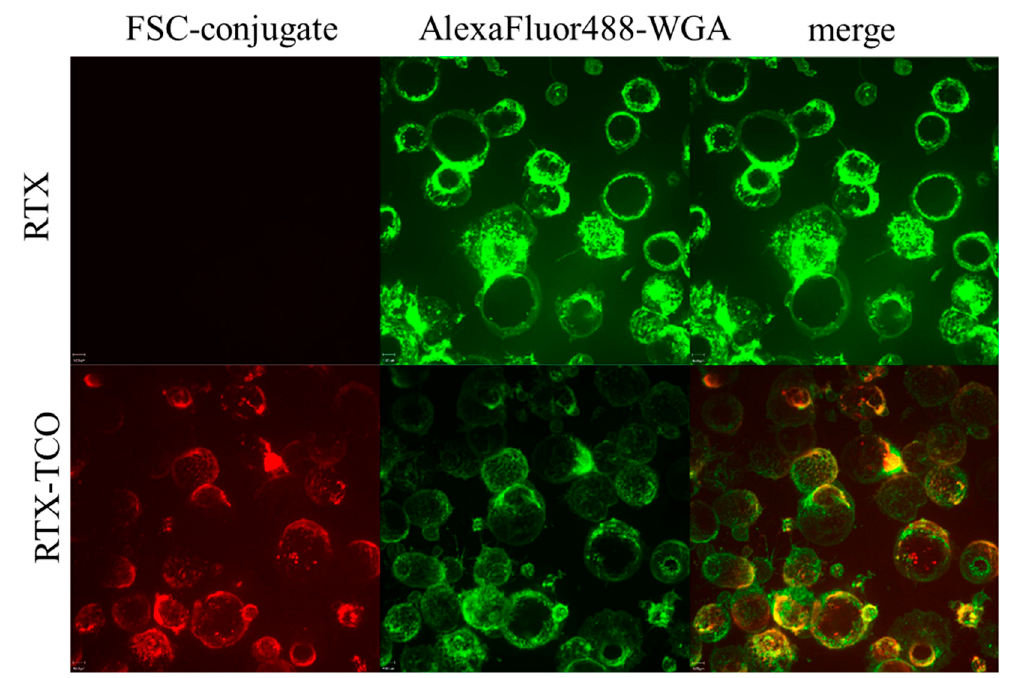
Figure 3. Fluorescence microscopy of CD20-expressing Raji cells pre-treated with RTX (upper lane) and with RTX–TCO (lower lane, negative control) prior to incubation with SulfoCy5-MAFC-PEG 5 -Tz. Each lane shows the fluorescence signal of the FSC-based conjugate (red), optical signal from AlexaFlour488-WGA labeled cells (green) and both images merged (from left to right).